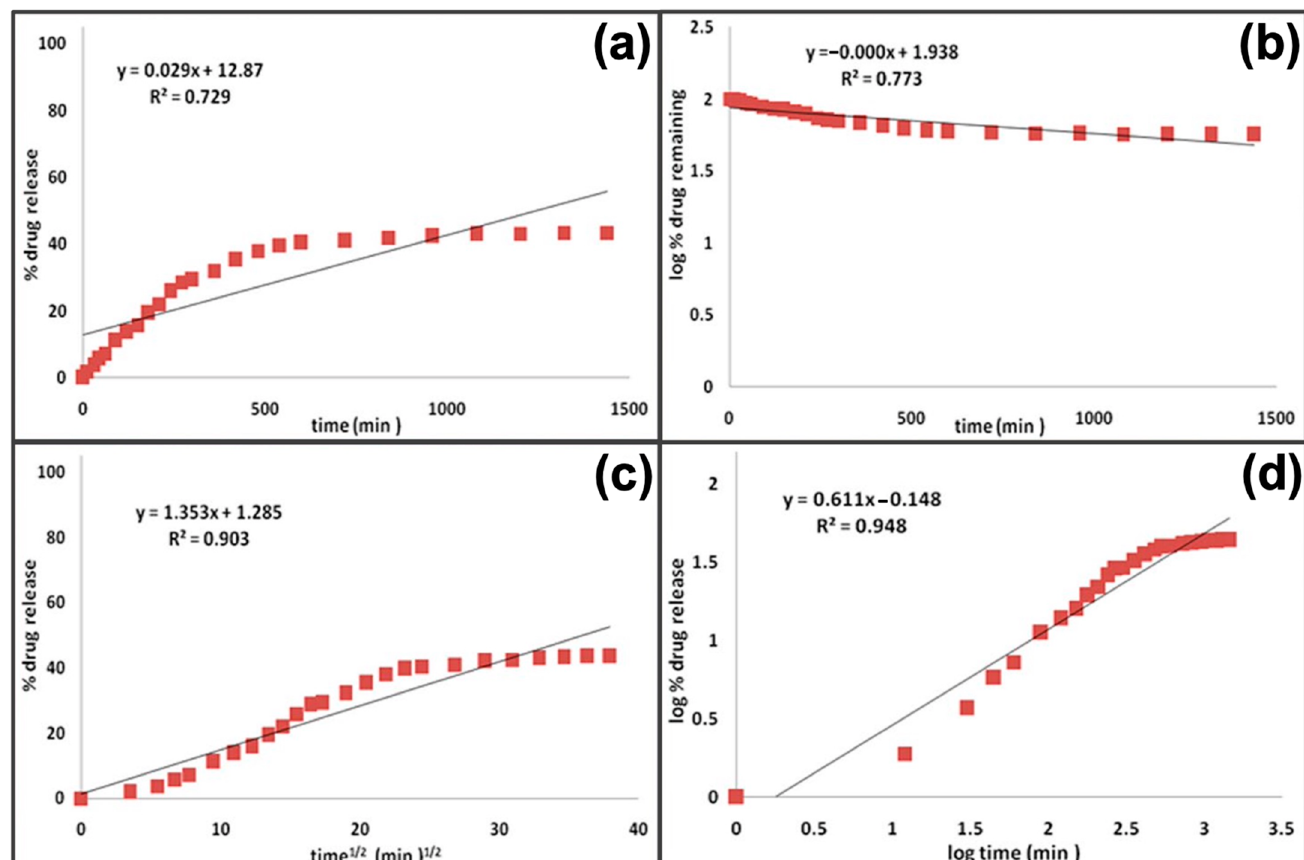
Figure 10. Comparison of different profiles of drug release kinetics: ( a ) Zero-order kinetic, ( b ) first- order kinetic, ( c ) Higuchi model, and ( d ) Korsmeyer–Peppas model. Reprinted from [161].